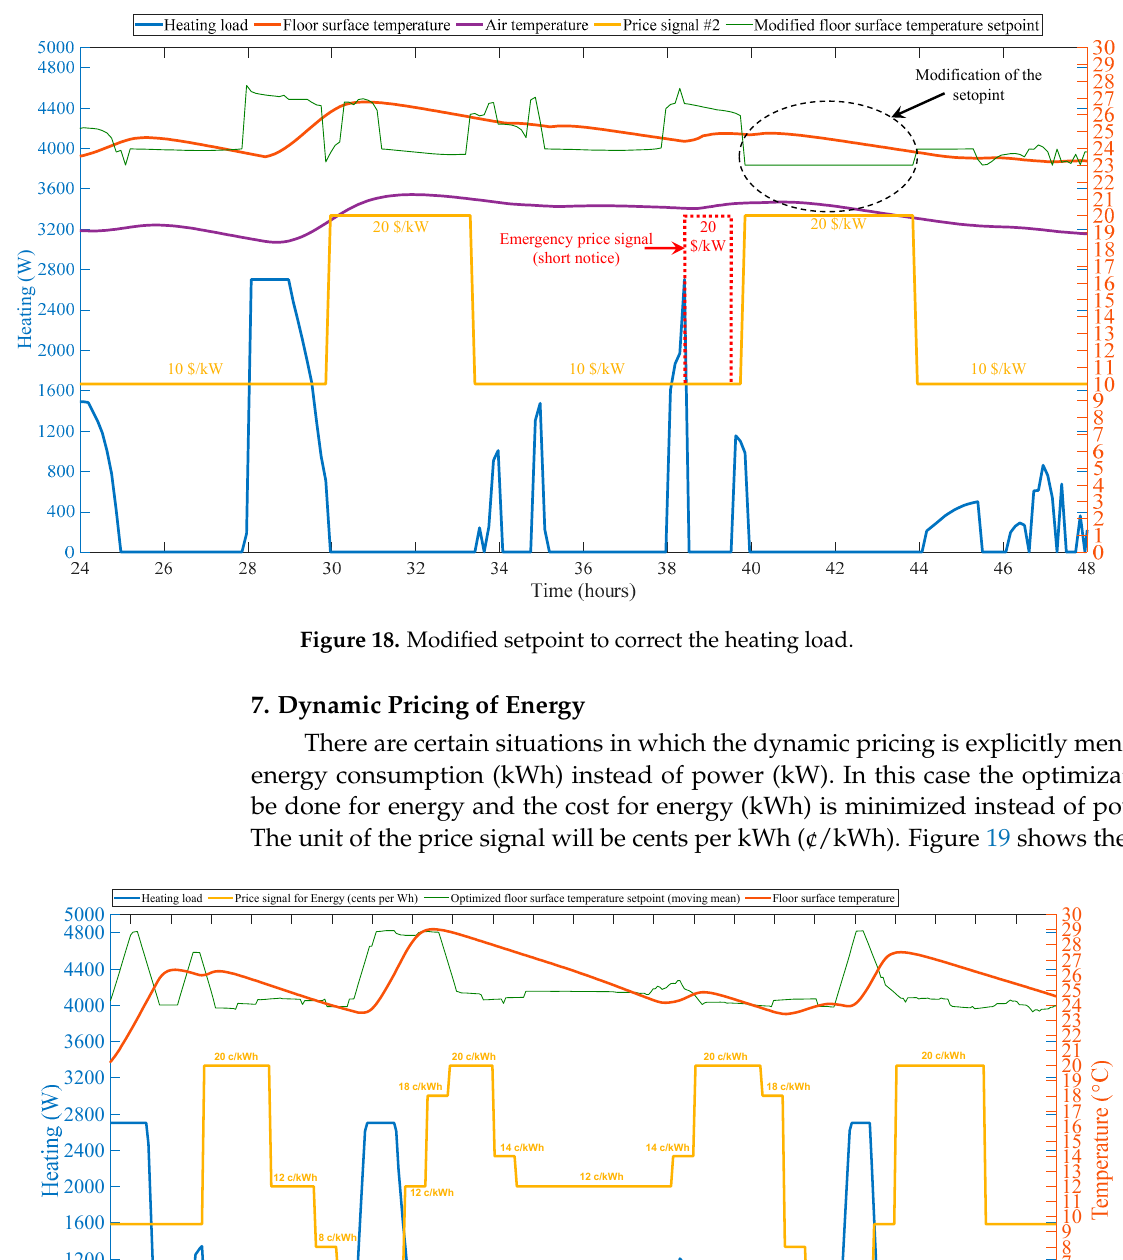
Figure 17. Unexpected change in the price signal.